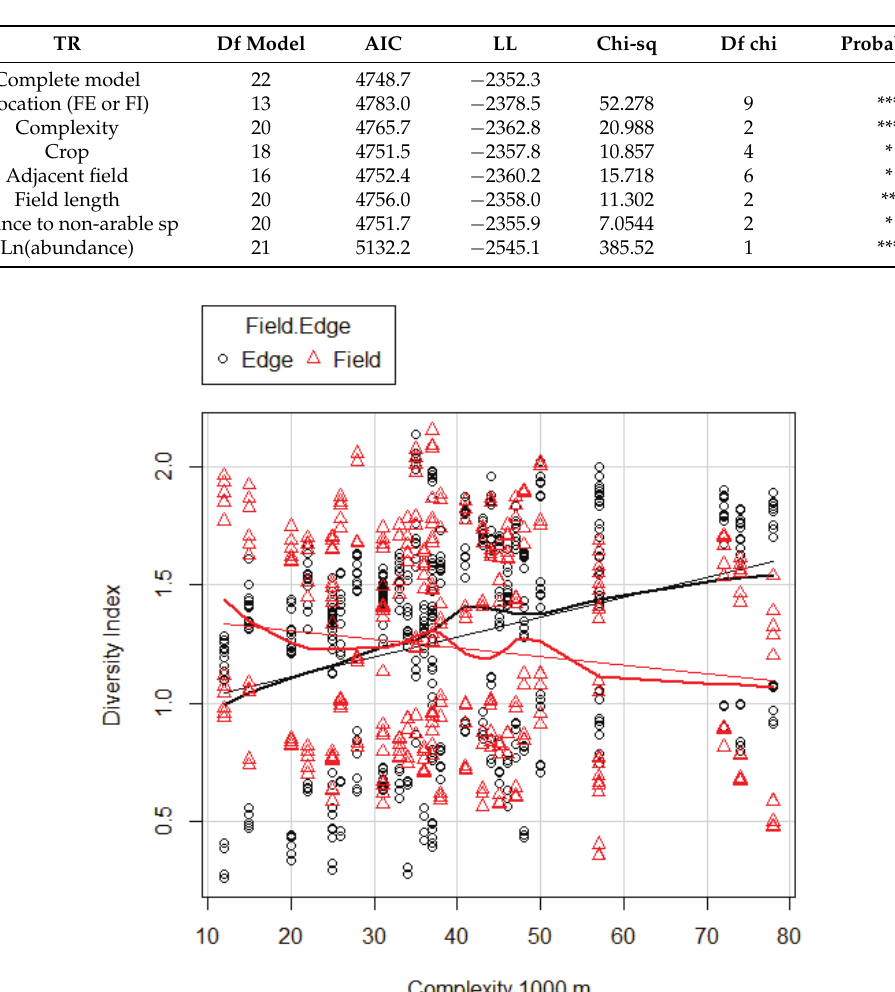
Figure 3. Diversity index (ln transformed) predicted by the best model for DI, Model 1000 (Table 9) in FE and FI as related to complexity at 1000 m. Thin line: linear regression line; thick line: non-linear regression line (LOESS curve).